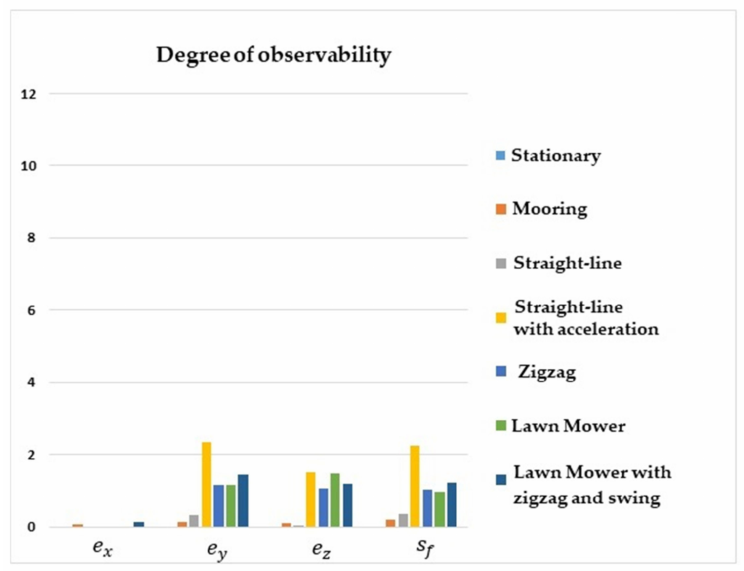
Figure 4. Degrees of observability of the IMU/DVL misalignment and the DVL scale factor error. INS/GPS/DVL/PS